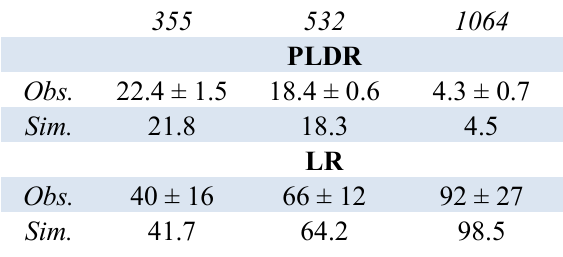
Table 1. Leipzig measurements vs T-matrix simulations for near spherical particles with mean axial ratio of